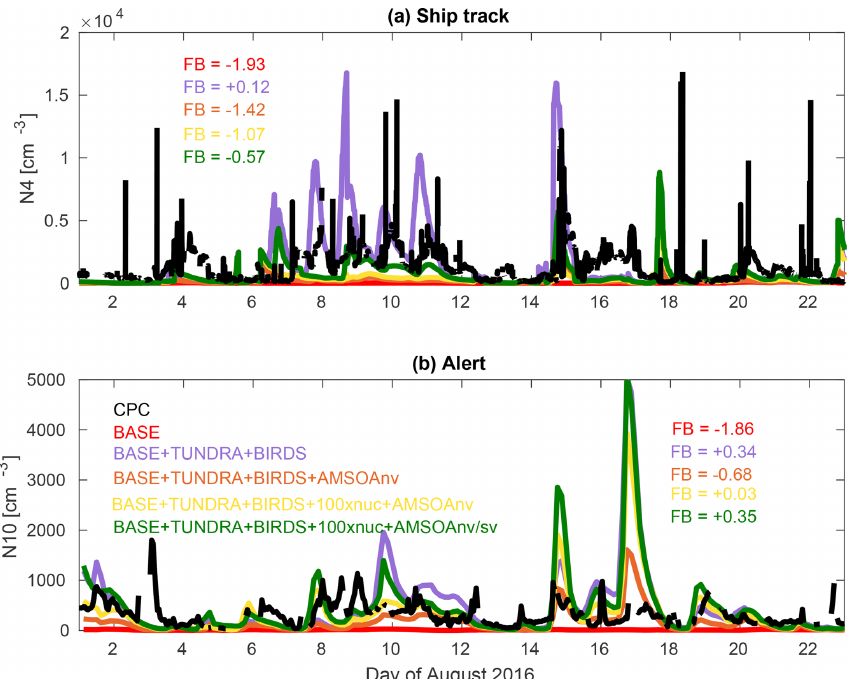
Figure 2. Time series for the August 2016 observed number concentration from the condensation particle counter (CPC) for aerosols with (a) diameters larger than 4nm (N4) along the Amundsen ship track (Fig. 1) and (b) diameters larger than 10nm (N10) at Alert (described in Sect. 2.1) as well as for the simulations as described in Table 1 and Sect. 2.3 (color coded as shown in the legend). FB refers to the fractional bias (defined in Sect. 2.2.5) between observations and simulations, color coded to match simulation